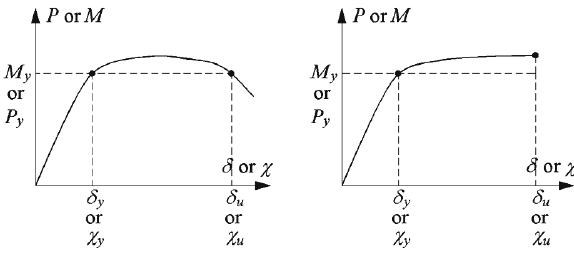
Fig. 6. Criterion: a) with intersection; b) no Table 5. Experimental values of ductility indexes Beam